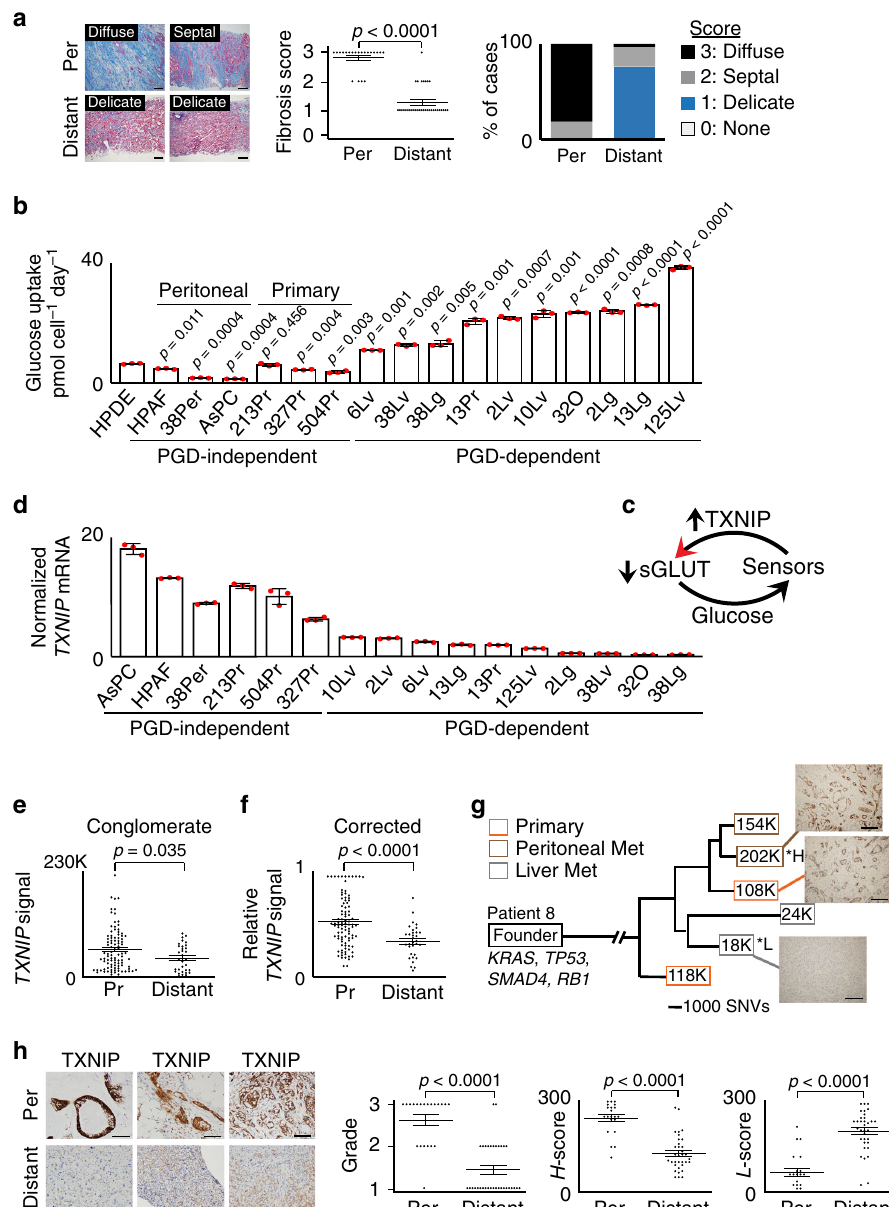
Fig. 1 TXNIP is recurrently suppressed in PDAC distant metastases. a (Left) Representative Masson ’ s trichrome stains for collagen (blue) shows metastatic peritoneal deposits (top, n = 21 individual patient samples) embedded within diffuse geographic (scored 3) or thick septal (scored 2) fi brosis. Delicate thin strands of fi brosis (scored 1) are instead present in distant metastases (bottom, n = 34 individual patient samples). Scale bars: 200 µ m. (Right) Graphical summaries of fi brosis scores (error bars: s.e.m., p <0.0001 by two-tailed t tests and two-sided Mann – Whitney U tests). b Glucose consumption rates were elevated for the indicated PGD-dependent cells, relative to the indicated PGD-independent control cells ( n = 3 technical replicates, error bars: s.d.m., indicated p values calculated by two-tailed t tests). c Illustration depicting how glucose-sensing negative feedback loops utilize TXNIP to prevent excessive glucose uptake. d TXNIP mRNA expression was downregulated in PGD-dependent subclones relative to PGD-independent controls ( n = 3 technical replicates, error bars: s.d.m.). e TXNIP transcript levels were lower overall in liver metastases (distant, average: 40,790, n = 32 separate metastases) than from multiregional areas in primary tumors (Pr, average: 59,653, n = 95 separate primary regions). Data represent total TXNIP read counts from RNA-seq datasets ( n = 10 total patients, error bars: s.e.m., p = 0.035 by two-sided Mann – Whitney U tests). f Similar results were obtained when TXNIP read counts were corrected for differences in baseline expression ( n = 95 primary tumor regions [Pr] and 32 liver metastases [Distant] from 10 total patients, error bars: s.e.m., p <0.0001 two-sided Mann – Whitney U tests). g Phylogenetic tree of patient 8 showing TXNIP expression for the indicated primary tumor subclones (orange boxes), metastatic peritoneal deposits (brown boxes), and liver metastases (gray boxes). Boxed values indicate TXNIP transcript expression from RNA-seq data (K units: thousands of read counts divided by the estimated tumor purity fractions, *H: highest, *L: lowest, SNV scale: single-nucleotide variants). IHC stains (connected by lines) con fi rmed loss of TXNIP protein in the indicated liver metastasis (scale bars: 200 µ m). Similar results were obtained for two other patients with available phylogenetic data (Supplementary Fig. 1e, f). h (Left) Representative IHC stains for TXNIP (brown) show diffusely strong reactivity in peritoneal metastatic cells ( n = 21 individual patient samples). Distant metastases show low or heterogeneous staining ( n = 34 individual patient samples). Scale bars: 200 µ m. Plots: IHC scored by a three-tiered grading scheme (left), H -scores weighted for high expression (middle), and H -scores weighted for low expression (right), as described in the “ Methods ” (error bars: s.e.m., p <0.0001 by two-sided Mann – Whitney U